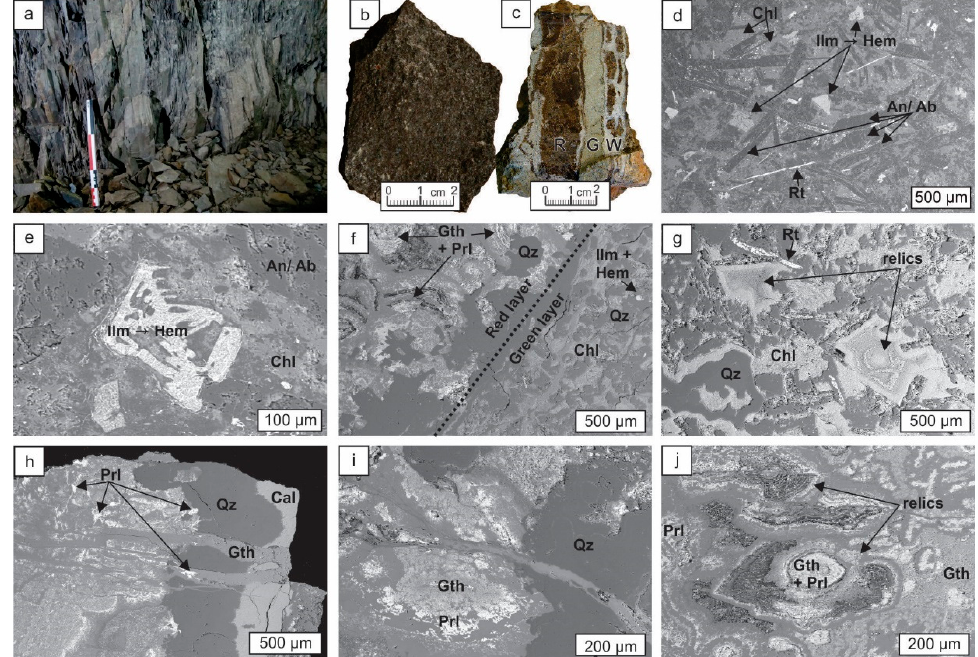
Figure 3. Host rocks ( d – j : SEM (Scanning Electron Microscope) photomicrographs, in backscattered electrons mode). ( a ) Paleozoic schisteous host rock (the scale is 30 cm long); ( b ) Permian-Triassic poorly weathered basalt; ( c ) most altered/weathered basalt composed of three different layers: red (R), green (G) and white (W); ( d ) poorly weathered basalt, with albite (Ab) and anorthite (An) laths, rutile (Rt), chlorite (Chl), and ilmenite (Ilm) weathered in hematite (Hem); ( e ) skeletal ilmenite (Ilm) presenting exsolution lamellae of hematite (Hem), in the poorly weathered basalt; ( f ) transition between the red and the green altered/weathered layers of the basalt, with goethite (Gth), pyrolusite (Prl), chlorite (Chl), quartz (Qz) and ilmenite-hematite (Ilm + Hem); ( g ) quartz (Qz), chlorite (Chl), rutile (Rt) laths, and relics of primary minerals in the green part of most altered/weathered basalt; ( h ) border between red and white parts of the most altered/weathered basalt, with quartz (Qz), calcite (Cal), goethite (Gth), and pyrolusite (Prl); ( i ) transition between the red and the white layers of the most altered/weathered basalt, with quartz (Qz), goethite (Gth), pyrolusite (Prl); ( j ) goethite (Gth) and pyrolusite (Prl) forming concentric structures in relation to relics of primary minerals, in the red part of most altered/weathered basalt.